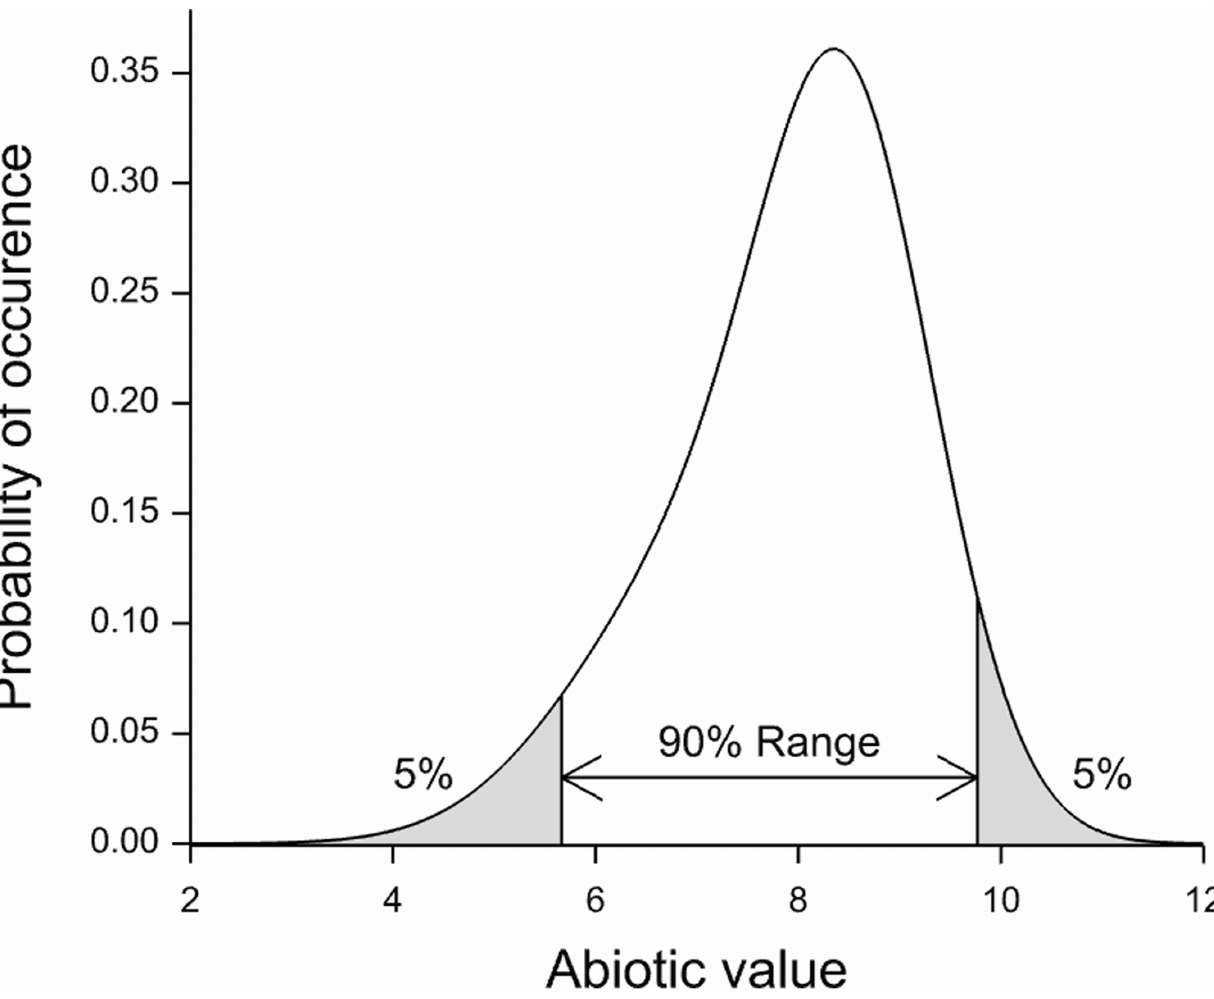
Figure 1. Hypothetical response curve (p-spline) for a hypothetical abiotic parameter, defining the range used in this research.